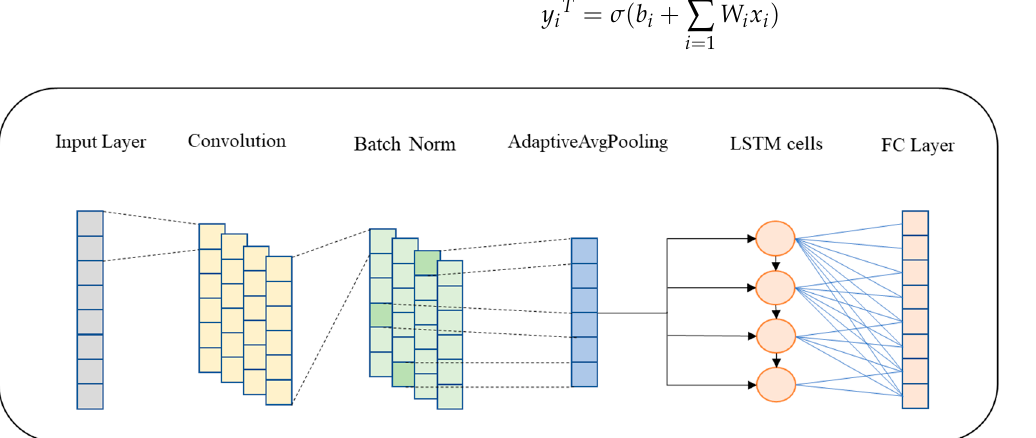
Figure 5. Specific network structure diagram.